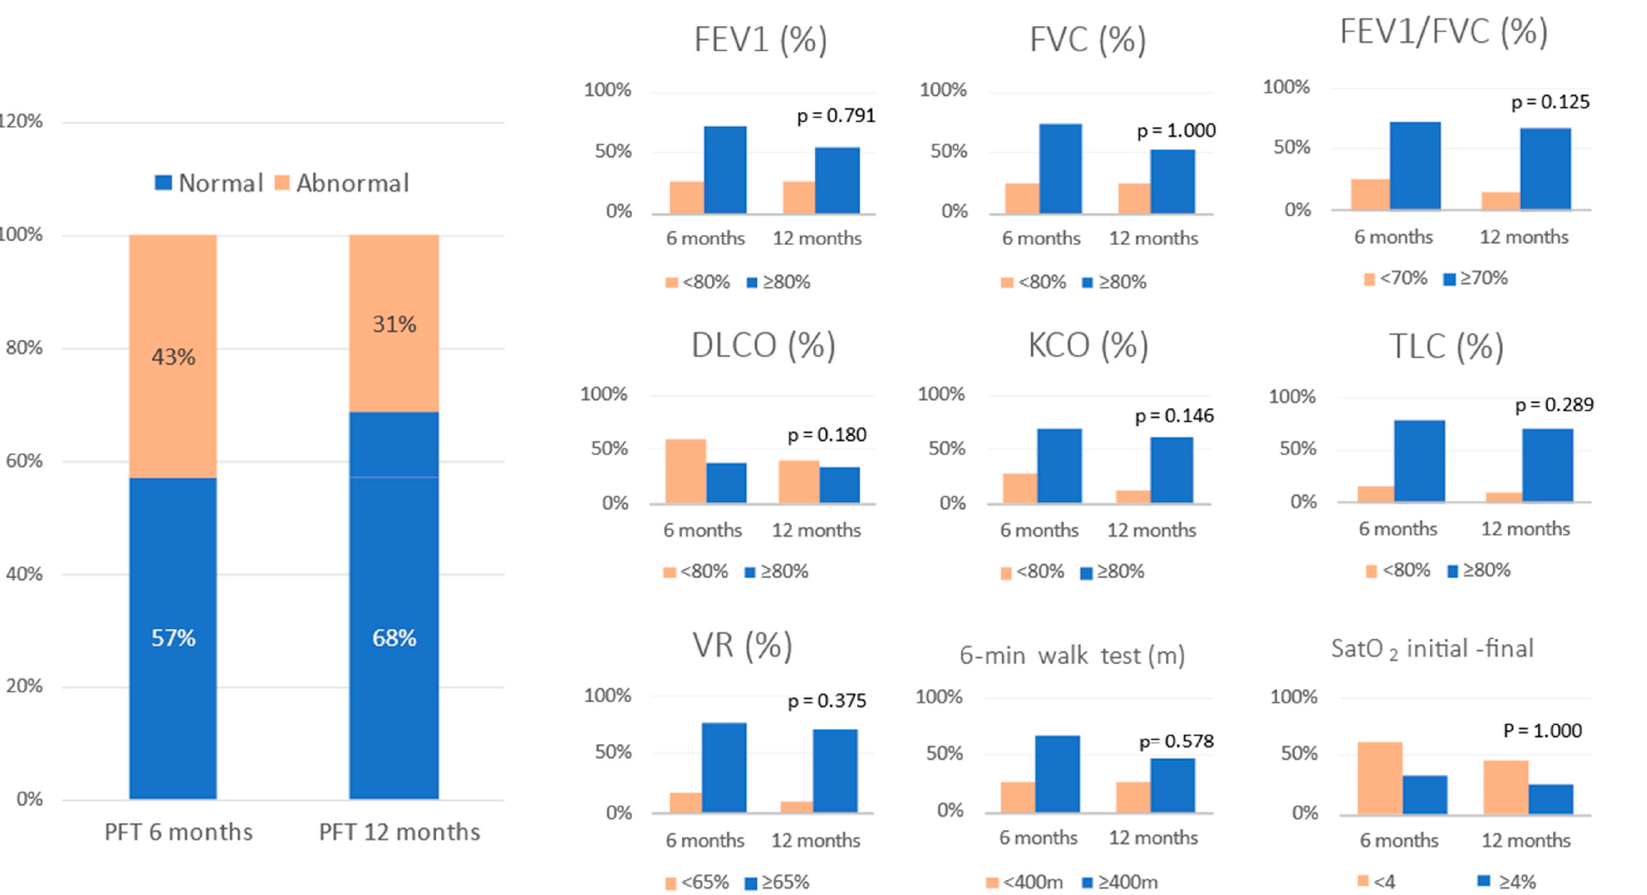
Figure 2. Evolution of pulmonary function tests at 6 and 12 months follow-up. Data are expressed as percentege (%). Abbreviations: FVC = forced vital capacity; FEV1 = forced expiratory volume in the first second; TLC = total lung capacity; RV = residual volume; DLCO = carbon monoxide transfer by single breath; KCO= diffusion constant for carbon monoxide; VR = residual volume; 6MWT = six-minute walking test; SatO 2 = oxygen saturation.